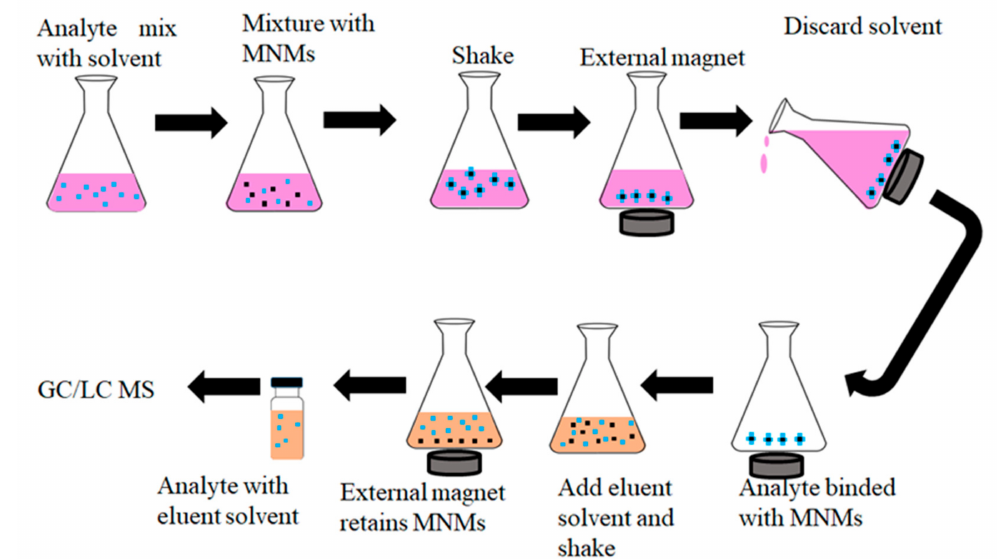
Figure 3. Diagrammatic illustration of magnetic solid phase extraction process for extraction of emerging